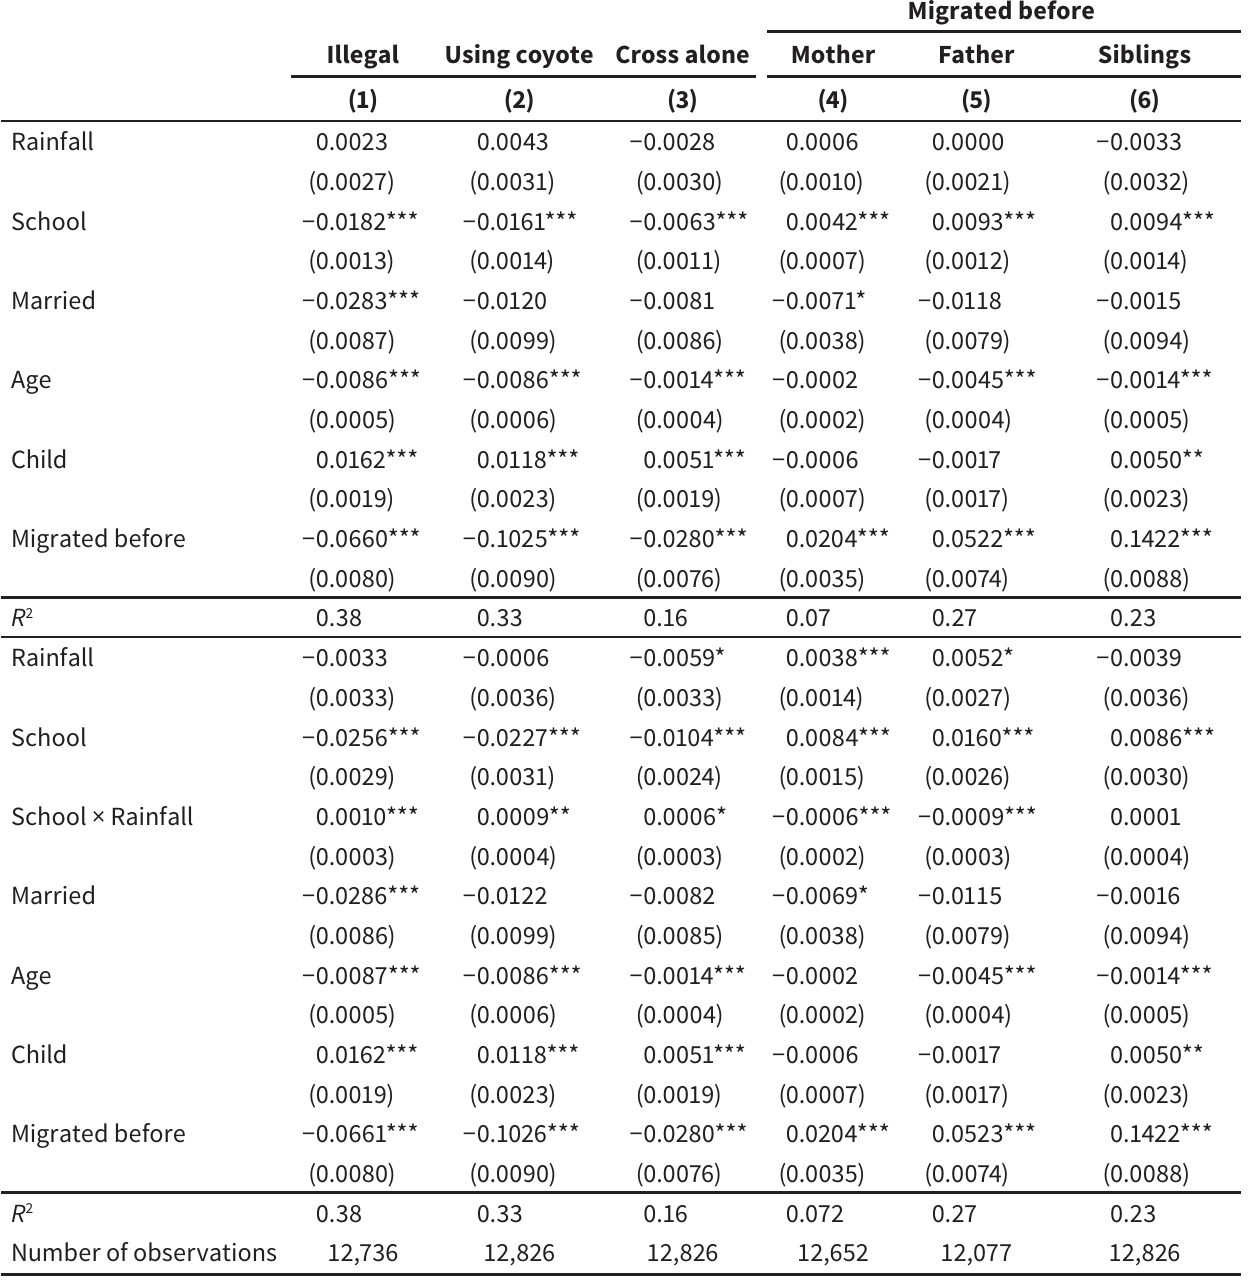
Relationship between rainfall and migration